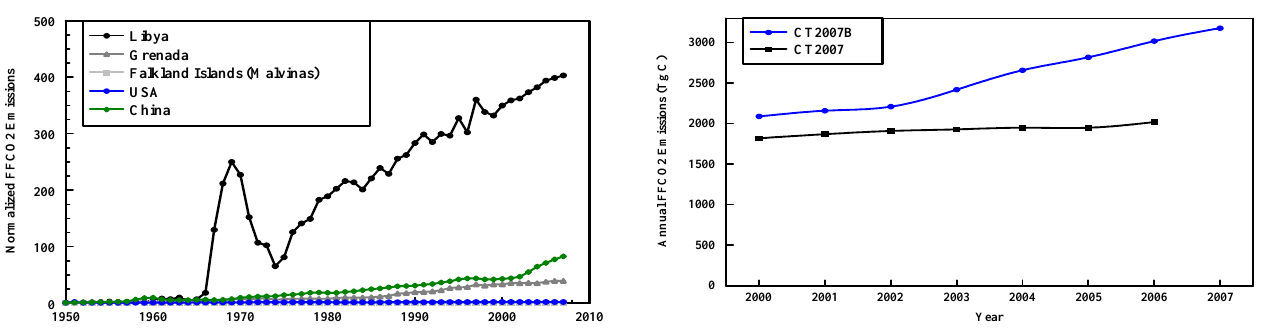
Fig. 5. Normalized national FFCO2 emissions for the years 1950 to 2007. This figure was created from the national consumption values (see section 1) and then normalized to 1950 emissions so that each country has a relative FFCO2 emission value equal to one in 1950. The U.S. curve lies nearly on top of that from the Falkland Islands. Data from Boden et al. (2010).